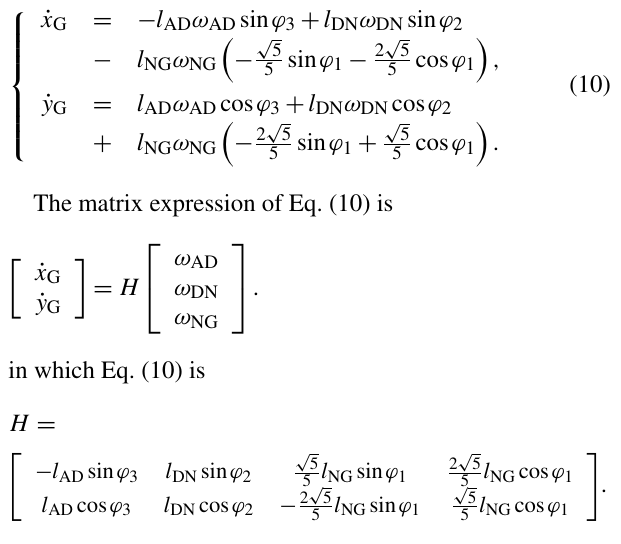
Figure 8. Curves of displacement, speed and acceleration of the roller during